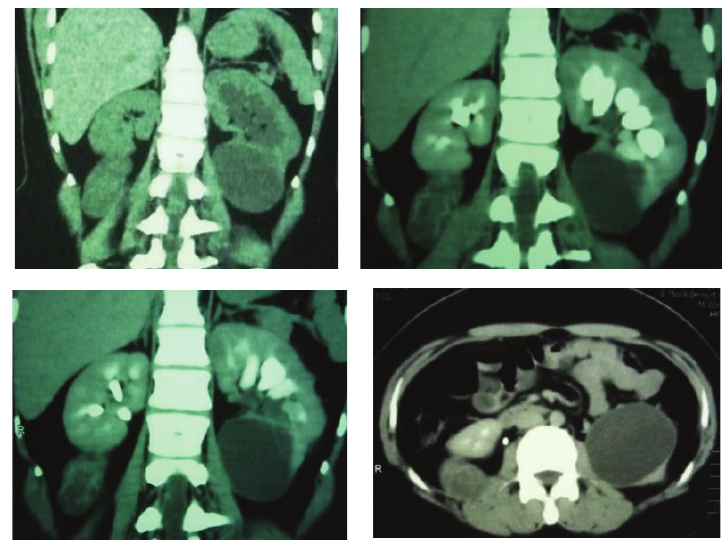
Figure 2: CT images demonstrate a retroperitoneal mass on the right side with heterogenous contrast enhancement and large cortical cyst in the lower pole of the left kidney with thin peripheral contrast enhancement without any other organ involvement.